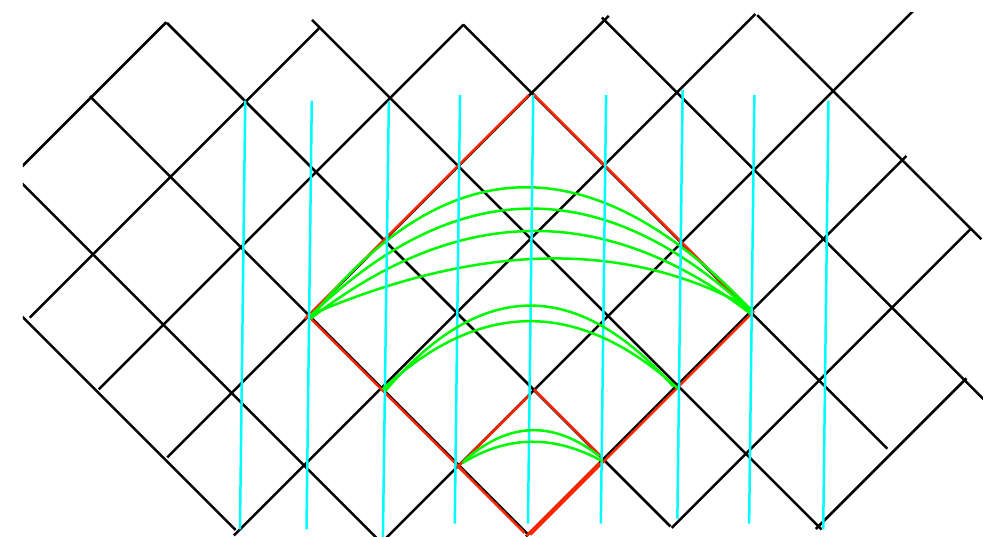
Figure 1. Holographic Inflationary Cosmology in Conformal Time: Equal Time Surfaces are Hyper- bolae Interpolating Between Diamonds. There are additional green spacelike surfaces that we have omitted for clarity, interpolating between those shown, such that the proper time between consec- utive surfaces along the central geodesic is always the Planck time. When a non-central geodesic penetrates the causal diamond of the central geodesic, consistency with the fact that that geodesic is still experiencing inflation implies that it must behave like an isolated quantum system with finite entropy given by the area